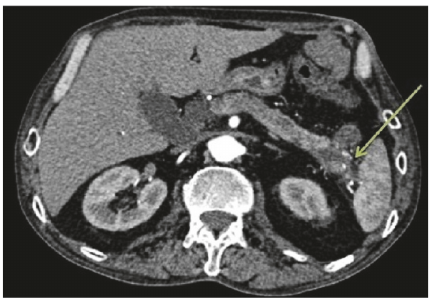
Figure 1: MRCP showing cystic foci in the pancreatic tail and colonic wall thickening. No strictures were noted. Green arrow denotes possible connection between the colon and pancreas.